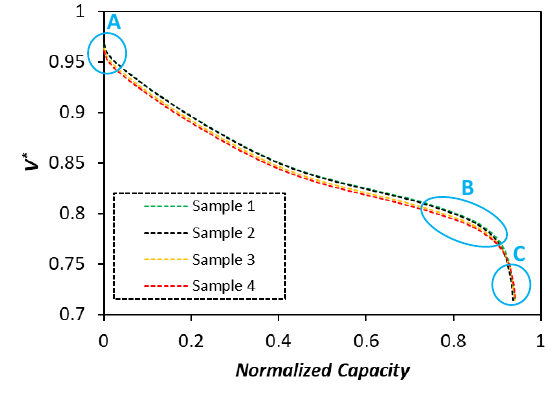
Figure 6. Experimental 1 C discharge curves for samples